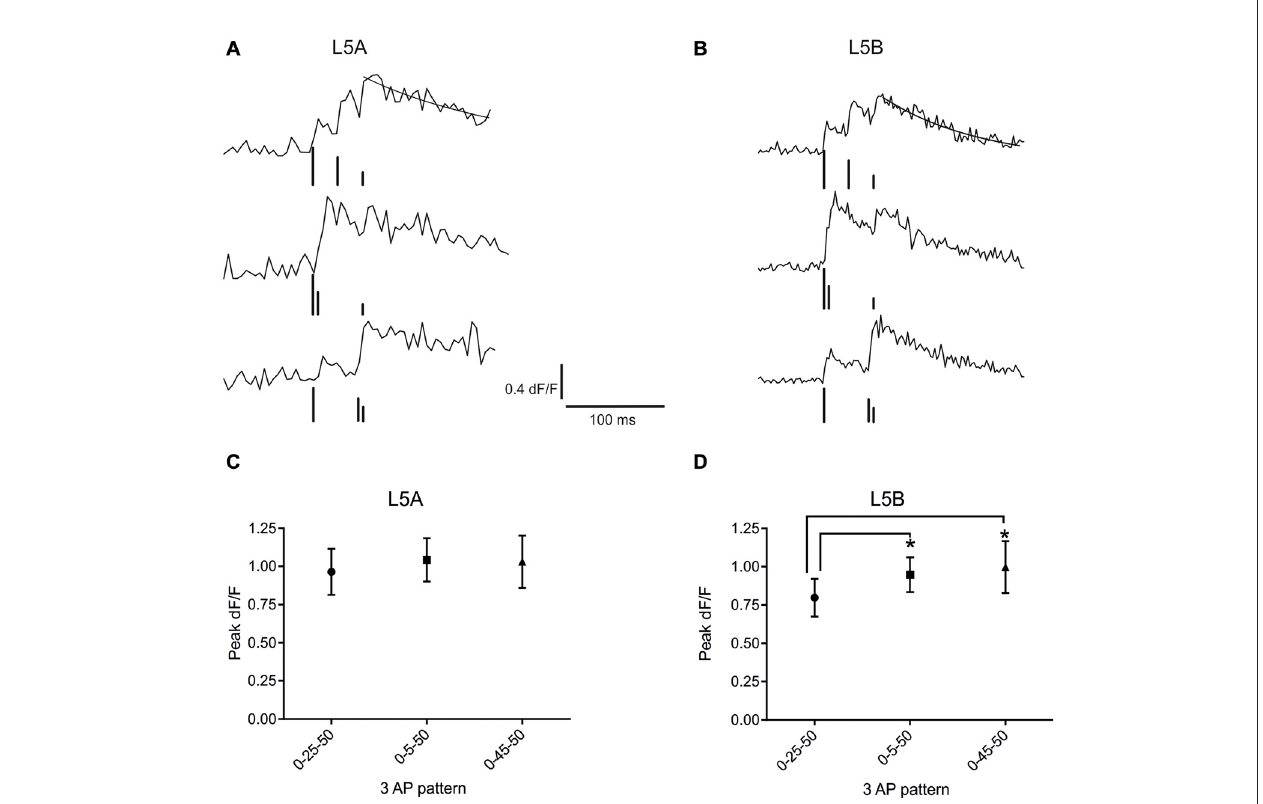
FIGURE 3 | bAP evoked calcium responses induced by artificial firing AP patterns. (A) An example of the bAP-evoked calcium responses evoked by the three different 3AP patterns in a L5A-st cell (measured at 68 µ m from the soma). The peak calcium response was calculated by fitting a standard exponential to the decay phase (black line). The black bars illustrate the time point of AP stimulation. The upper trace corresponds to the 0–25–50 ms stimulus, middle trace: 0–5–50 ms and the lower trace: 0–45–50 ms. The vertical lines are drawn at different heights, for the purpose of clarity. (B) Representative example of the bAP-evoked calcium responses measured in a L5B-tt cell (154 µ m from the soma) and induced by the same three 3AP patterns used in (A) . Analyzing the three different 3AP patterns separately shows that in L5A cells (C) there was no effect of a high frequency component (200 Hz interspike interval, ISI) in the 3AP trains (averaged from dendritic spots at 40–254 µ m), whereas in L5B cells (D) the two 3AP patterns with a high frequency component evoked a larger calcium response compared to the 3AP pattern with a 40 Hz ISI (averaged from dendritic spots at 57–168 µ m). ∗ P <